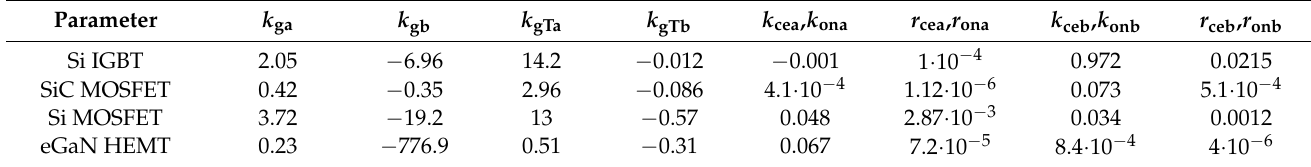
Table 3. Key fitting coefficients parameters of different semiconductors.